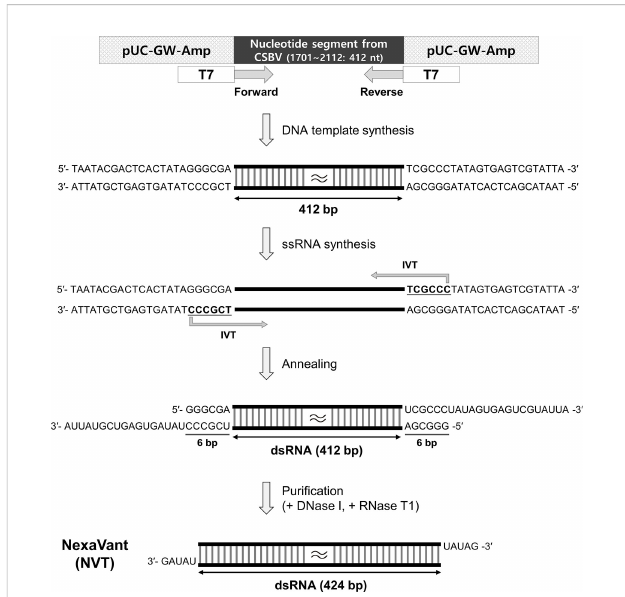
FIGURE 1 Schematic illustration of NexaVant (NVT) synthesis. The partial nucleotide segment (1701-2112; 412 nucleotides) from the CSBV genome was cloned into the vector. Forward and reverse PCR primers containing the T7 RNA promoter sequence were designed for the DNA template. After in vitro transcription (IVT) on the DNA template, complementary RNA strands were annealed to form dsRNA. Template DNAs and non-speci fi c ssRNAs were removed with the treatment of DNase I and RNase T1 to generate a dsRNA structure having UAUAG- 3 ′ at both ends and the fi nal product was puri fi ed through column puri fi cation. nt, nucleotide.